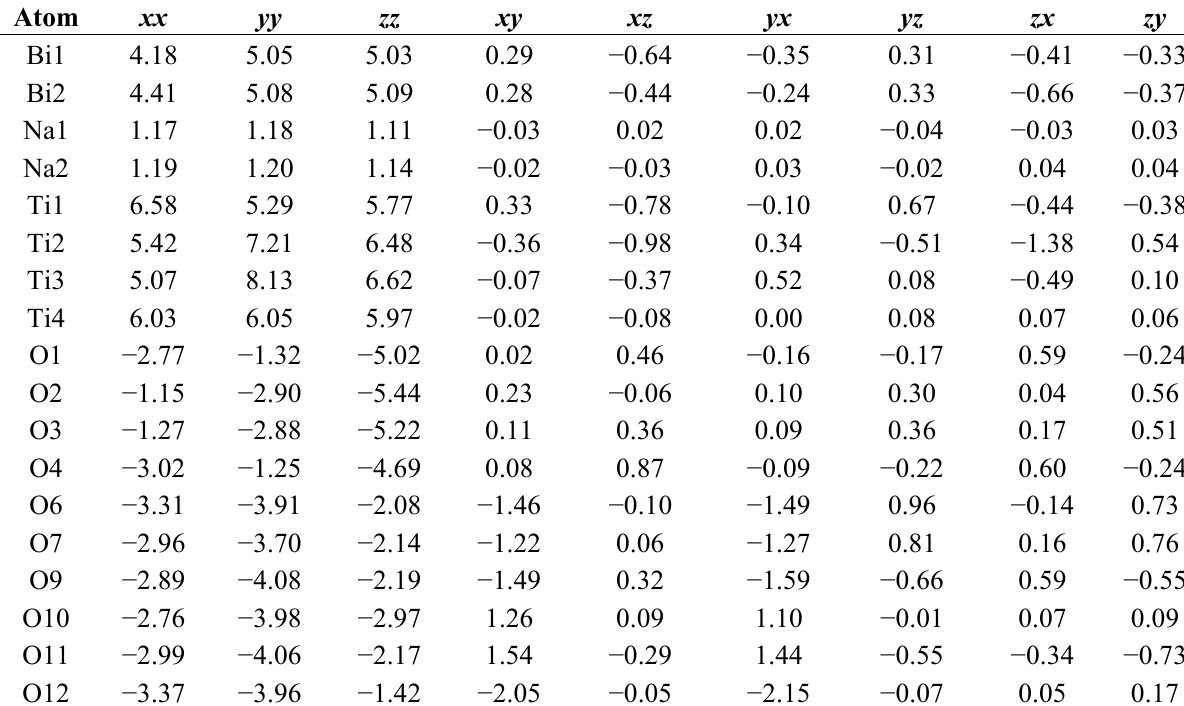
Table 4. Born effective charge ( Z *) tensors of the constituent atoms obtained for the Pc cell calculated using the unit-cell parameters of BNT ( E the Z * tensors are listed